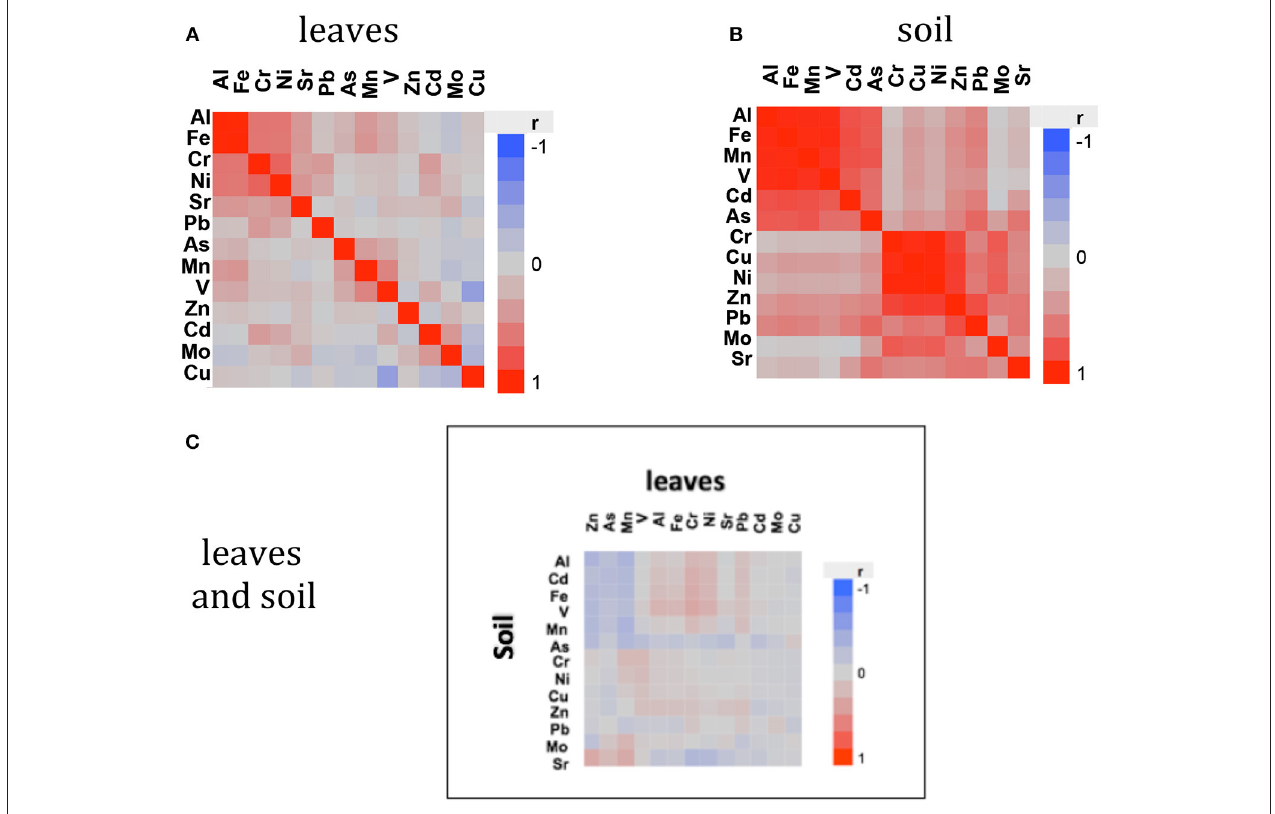
FIGURE 4 | Correlation heat plot showing the correlation (r) of metal concentrations in the leaves (A) , soil (B) , and between metals in leaves and soil (C)